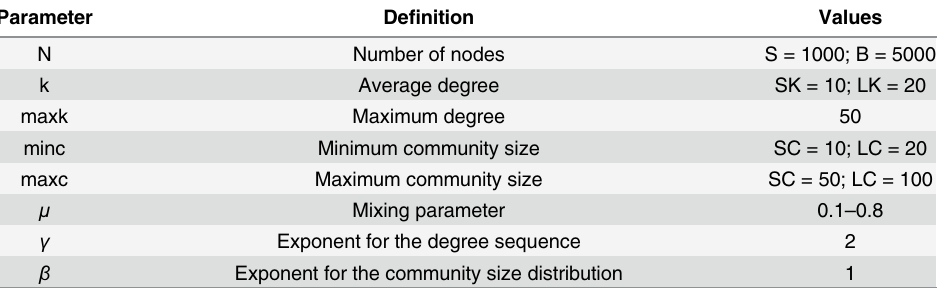
Table 2. Summary of the generated LFR networks.